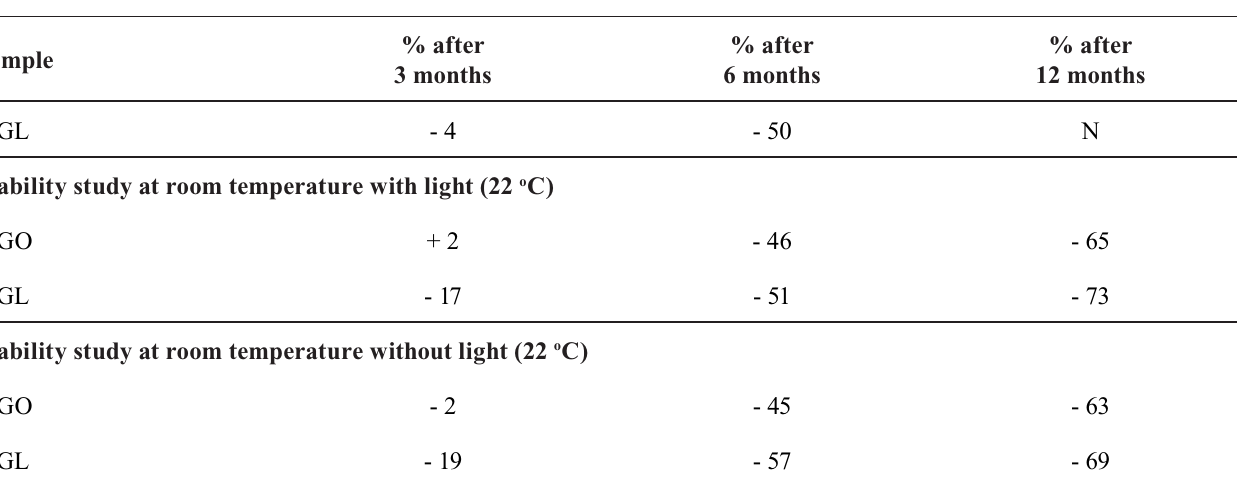
TABLE II - Percentage of chlorogenic acid reduction for the evaluated extracts